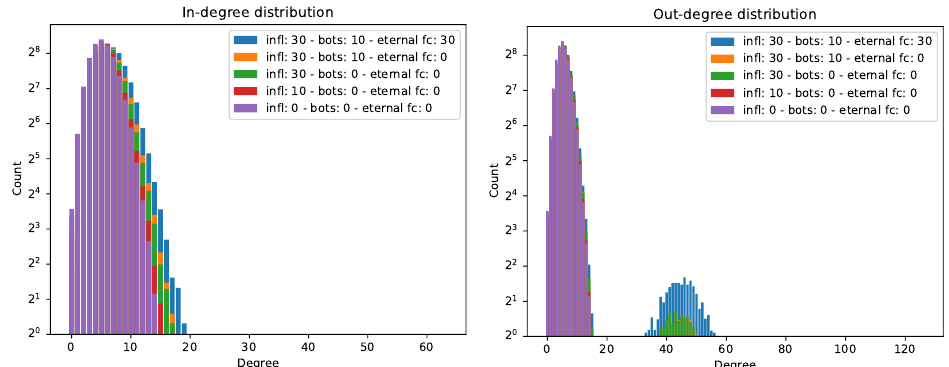
Figure 2. In-degree ( left ) and out-degree ( right ) distributions for the networks considered in the experiments. The presence of bots and influencers with a large degree distribution yields the second out-degree peak between degree values of 30 and